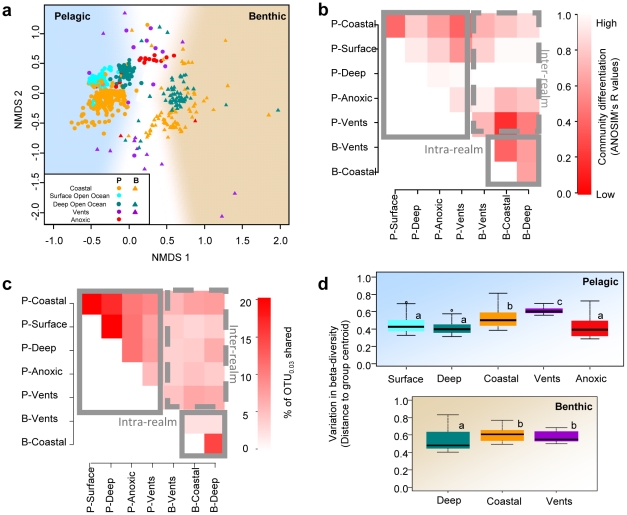
Global beta-diversity patterns of marine bacterial communities according to realms and ecosystem types.(a) NMDS ordination of the dissimilarity in bacterial community composition (OTU0.03 level, NMDS stress = 0.18). (b) Heat map showing pairwise community overlap (upper-half symmetric matrix displayed) according to realm/ecosystem. All ANOSIM R values were significant (1000 Monte Carlo permutations, Bonferroni-corrected P<0.05). (c) Heat map of the average number of OTU shared between ecosystems types, based on random resampling of 100 subdatasets. (d) Boxplots of the variation in beta-diversity in each ecosystem type. Different letters on each box represent significant differences in variance homogeneity between ecosystem types as determined by Mann–Whitney rank sum tests followed by Bonferroni correction (P<0.01).